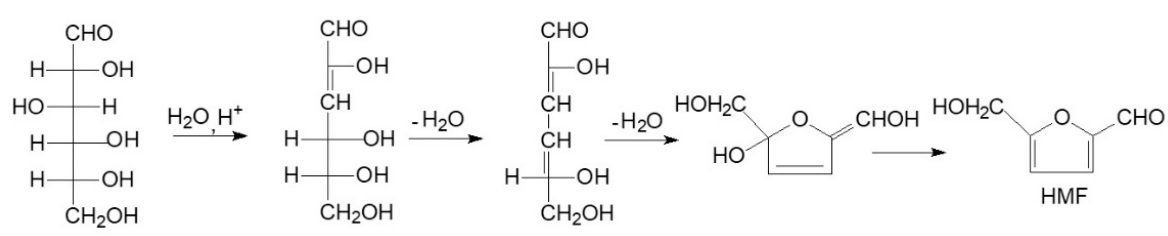
which it begins to decrease up to a 45 min reaction time. Alinia et al. [25] obtained the best overall yields for sugar (208 g kg − 1 ) with supercritical CO 2 pretreatment at 185 ◦ C for a 30 min reaction time for wheat straw. The proposed mechanism for the transformation of hexoses into HMF is presented in Figure 6.